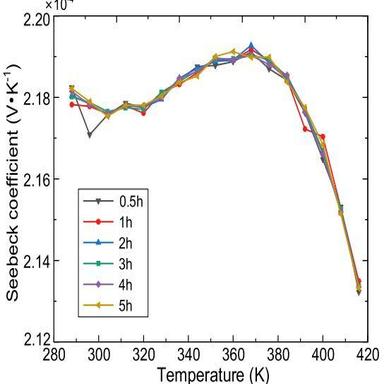
The impacts on the accuracy of the characterized parameters from the heating rates using the QSS method.